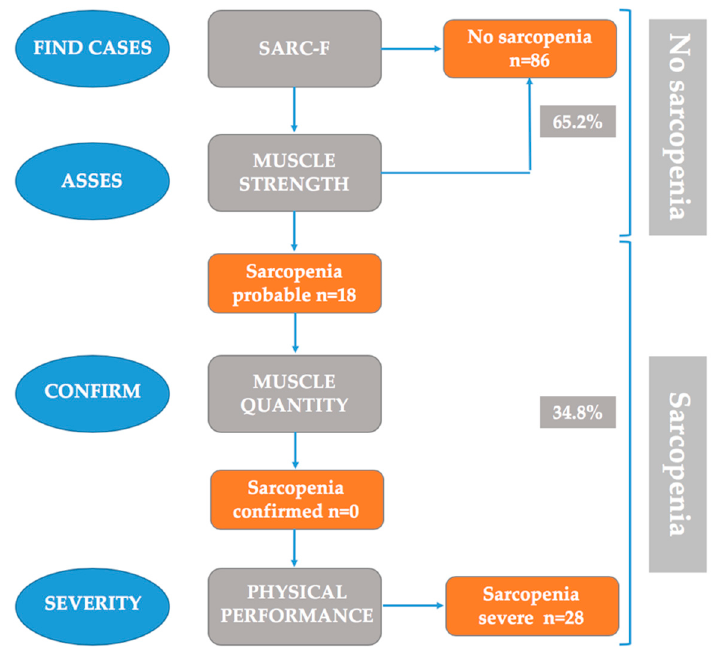
Figure 1. Sarcopenia: EWSGOP2 algorithm for case-finding, diagnosis and quantification of severity in practice.